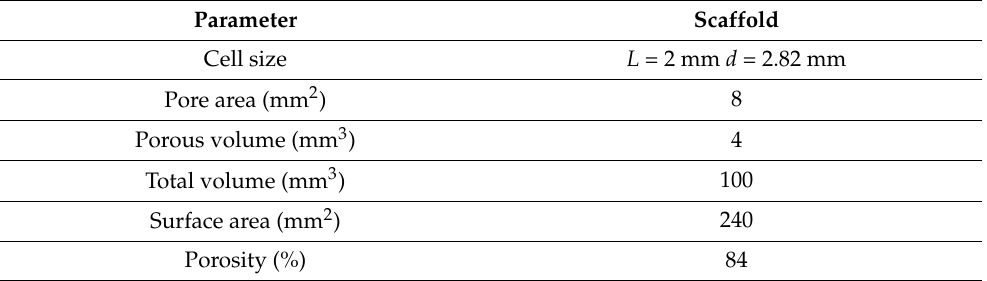
Table 3. Characterisation of the scaffold.